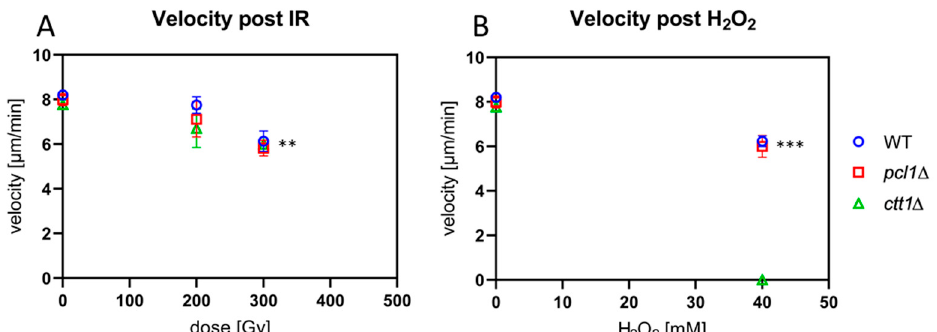
Figure 5. The e ff ect of ROS stress on meiotic chromosome motility. ( A ) Exposure to 300 Gy X-IR reduced the average velocity of horsetail nuclei in wild-type, pcl1 ∆ and ctt1 ∆ strains significantly (** p ≤ 0.005) relative to sham-irradiated control. ( B ) H 2 O 2 treatment (40 mM) significantly reduced average horsetail speed for the WT and pcl1 ∆ strains (*** p = 0.0003, p = 0.0002, respectively), relative to non-exposed control. H 2 O 2 treatment killed ctt1 ∆ meiocytes. Data points reflect the mean of three experiments (± SD).